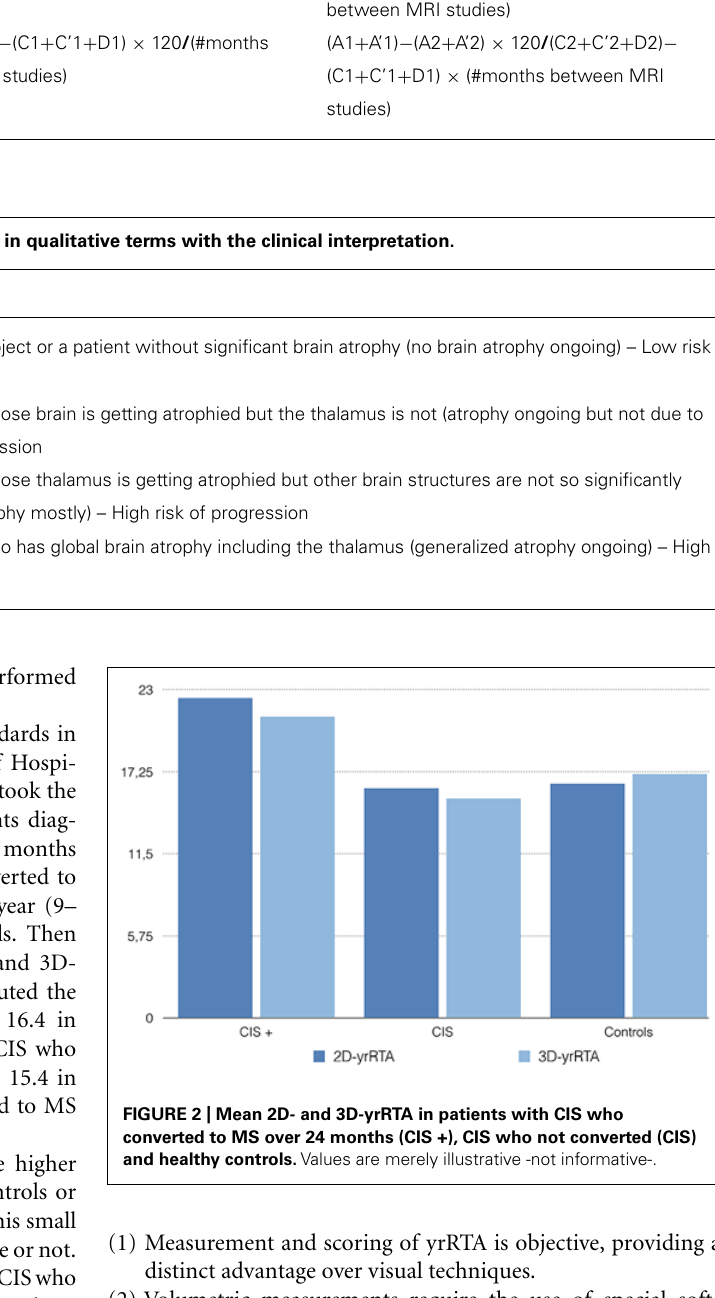
Table 1 | Formule for computing the yrTA, yrVE, and yrRTA under 2D and 3D methodologies. yrTA yrVE yrRTA 2D